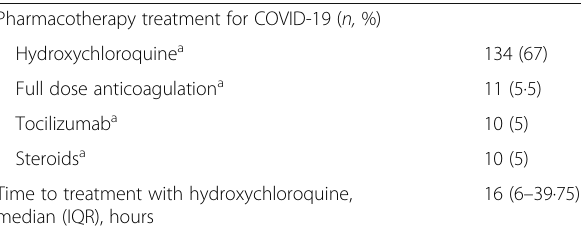
Table 7 COVID-19 management ( n = 200) Pharmacotherapy treatment for COVID-19 ( n, %) Hydroxychloroquine